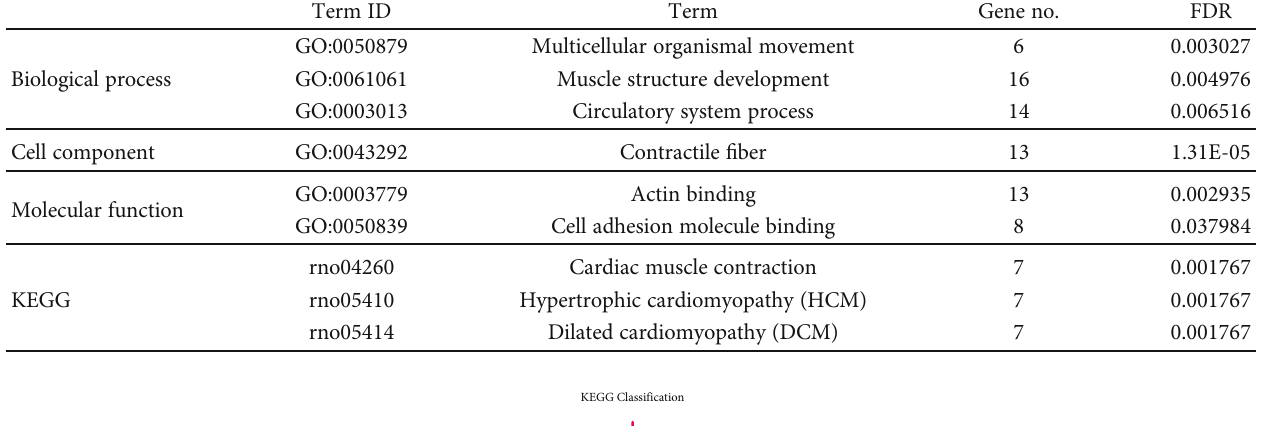
Table 3: Functional enrichment analysis of downregulated expression DEGs.